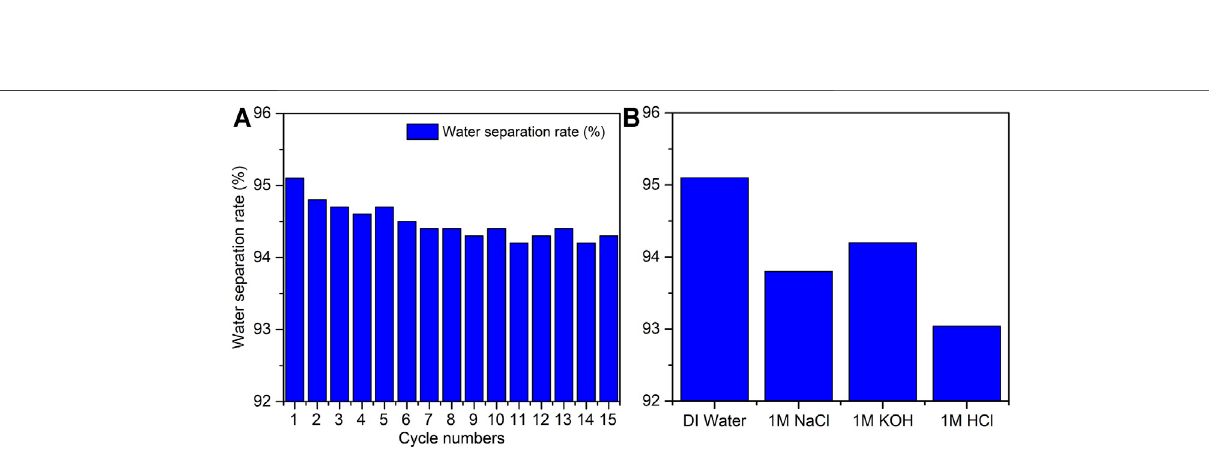
Frontiers in Chemistry |